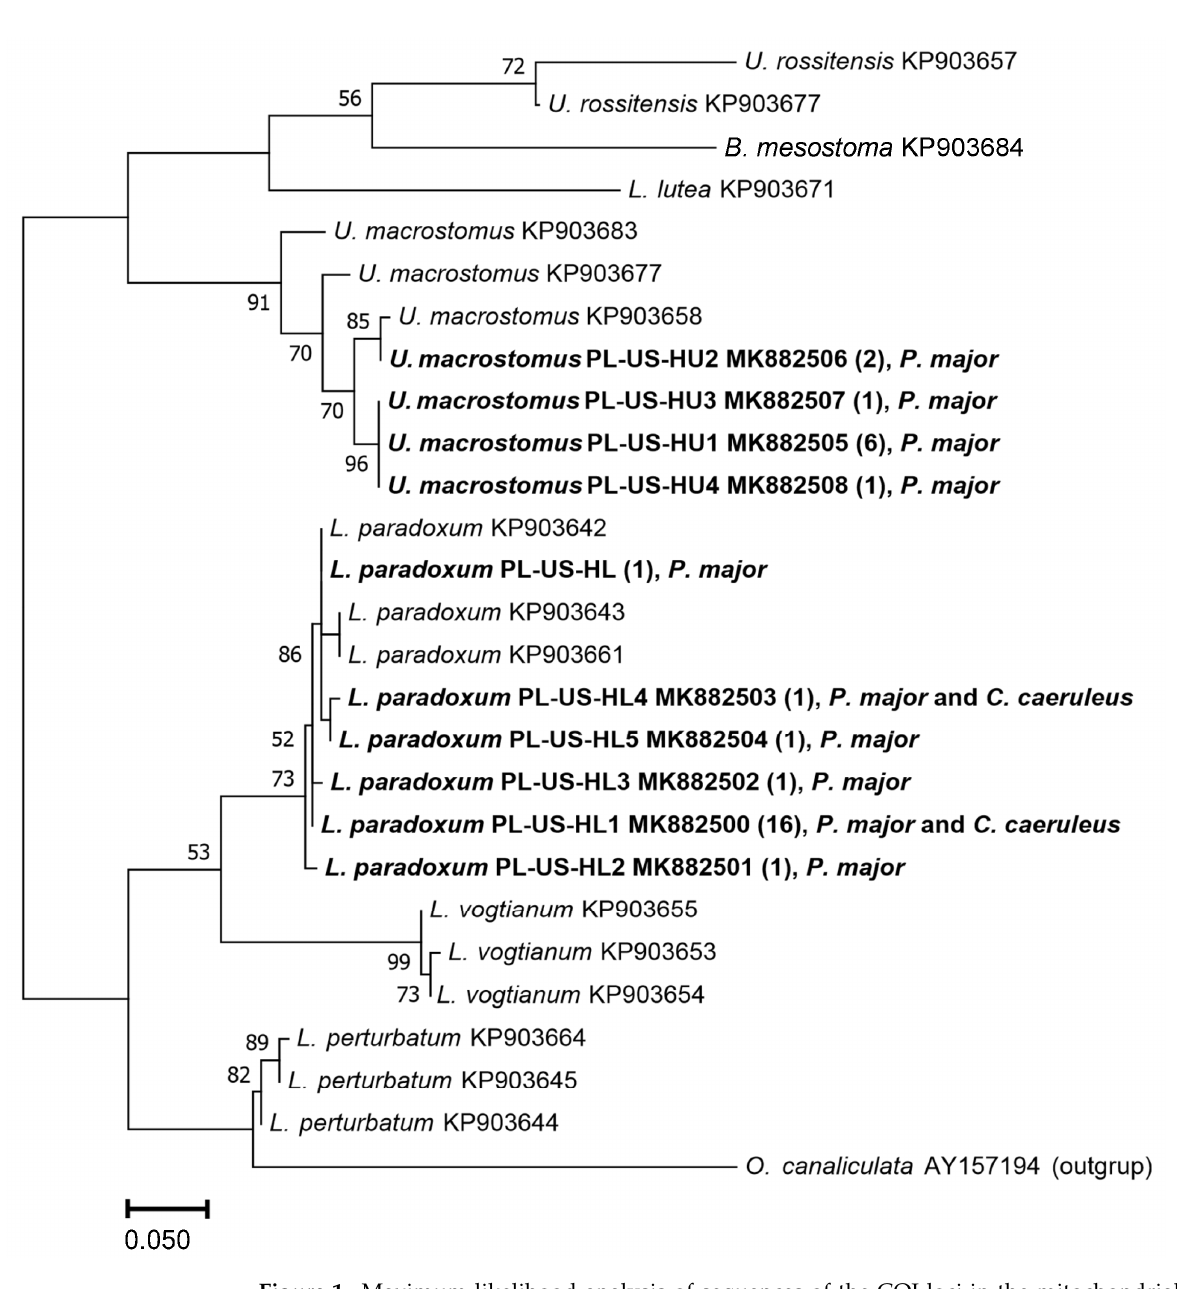
Figure 1. Maximum likelihood analysis of sequences of the COI loci in the mitochondrial DNA of flukes Parus major and Cyanistes caeruleus. Bootstrap values expressed as percentages from 1000 replicates are given next to each branch. Values less than 50% are not shown. Results (haplotypes, hosts) obtained in this study are in bold. Numbers of flukes with a given haplotype are given in brackets.